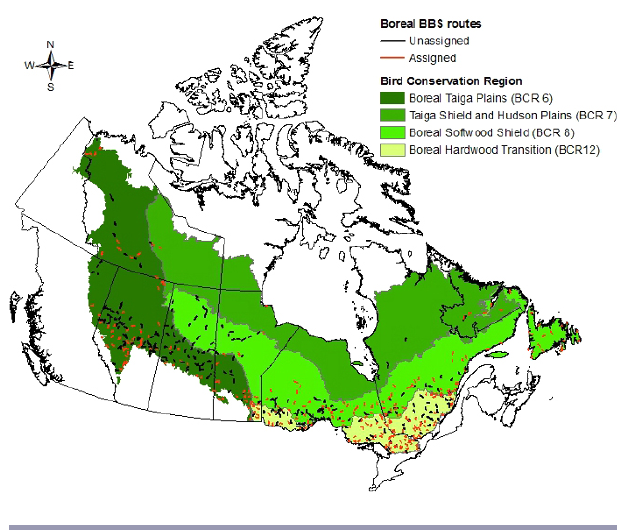
Fig. 1 . Distribution of assigned and unassigned North American Breeding Bird Survey (BBS) routes and study area extent based on the portion of boreal Canada for which anthropogenic disturbance data (Pasher et al. 2013) are available. BCR indicates bird conservation